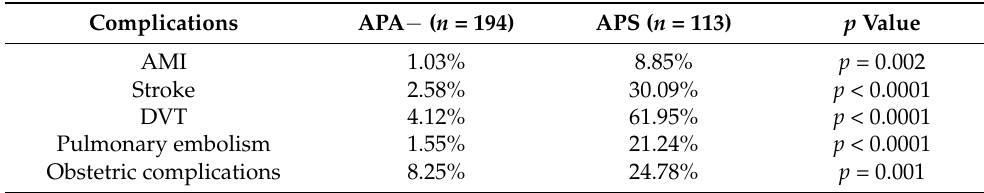
Table 2. Prevalence of thrombotic manifestations and pregnancy complications in the groups of APA negative lupus patients and secondary APS patients.